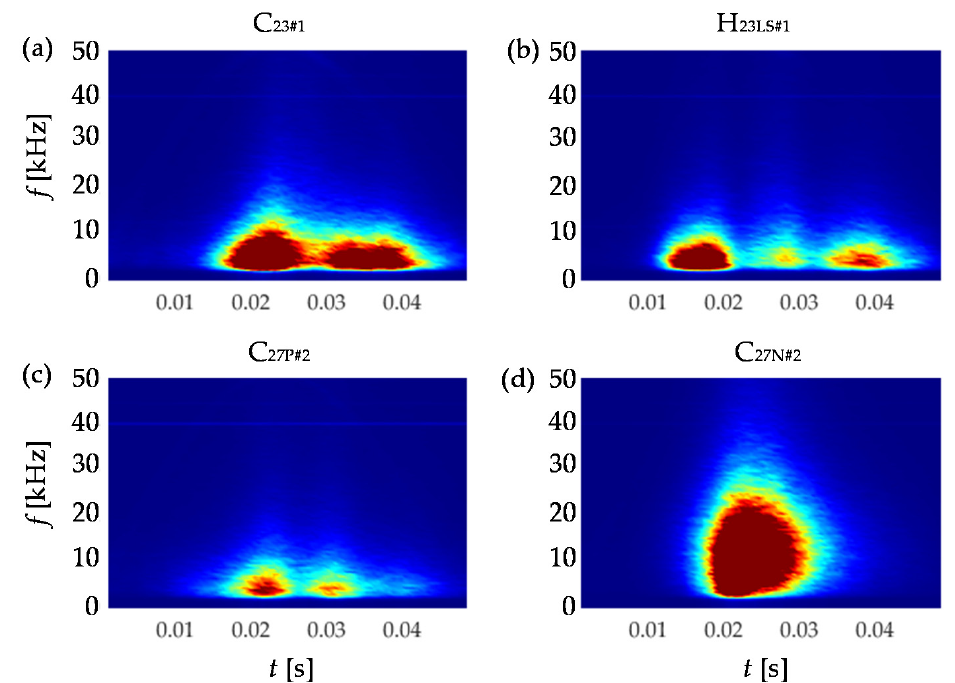
Figure 3. Exemplary TF spectrograms obtained for alignment of the transducer along the rolling direction RD for four different test samples: ( a ) CGO steel sample with thickness of 0.23 mm (C 23#1 ), ( b ) high GO steel sample after laser scribing (H 23LS#1 ) ( c ) CGO steel sample with thickness of 0.27 mm after decoating of the oxide layer (C 27P#2 ) and ( d ) CGO steel sample with thickness of 0.27 mm after nitriding process (C 27N#2 )